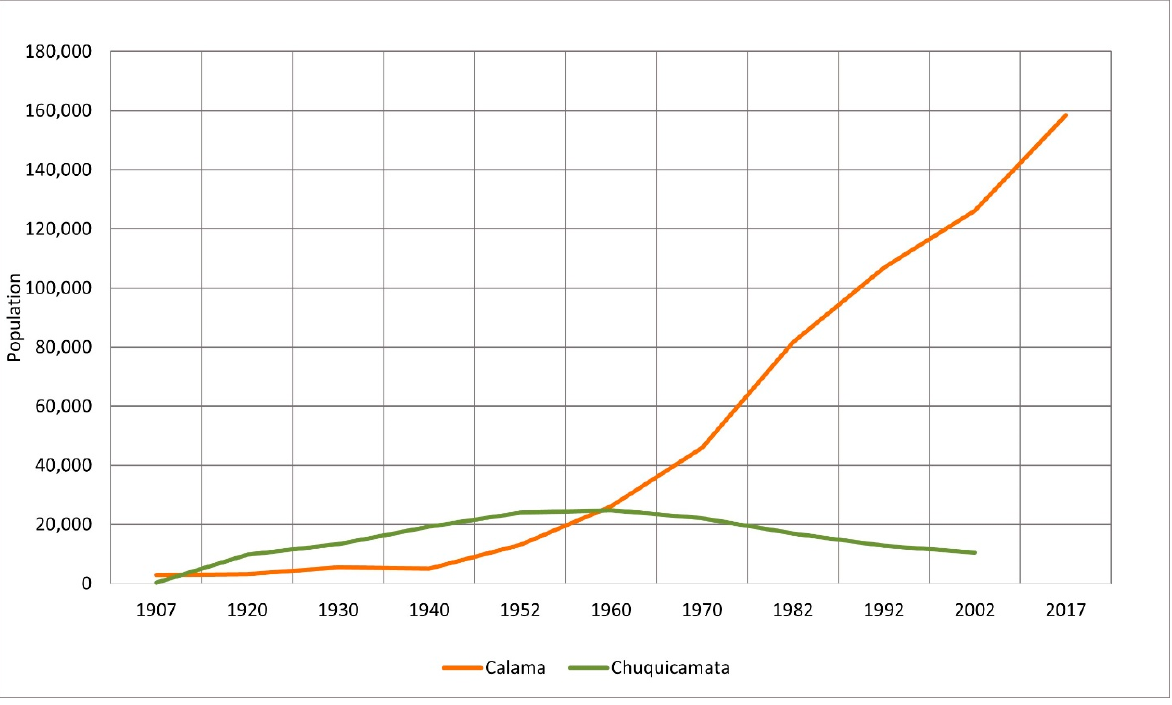
Figure 4. Population growth in the cities of Calama and Chuquicamata.